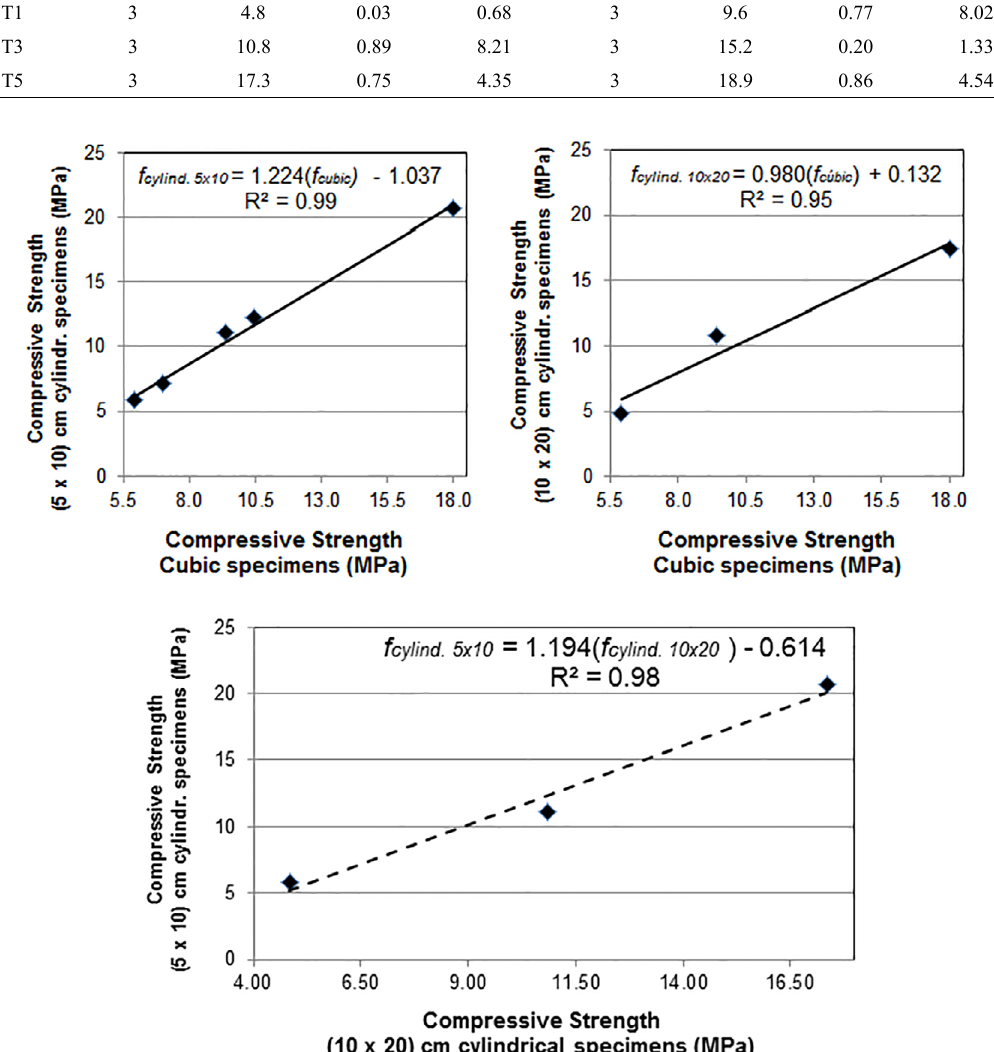
Figure 4. Correlations between compressive strength of specimens of different shapes and